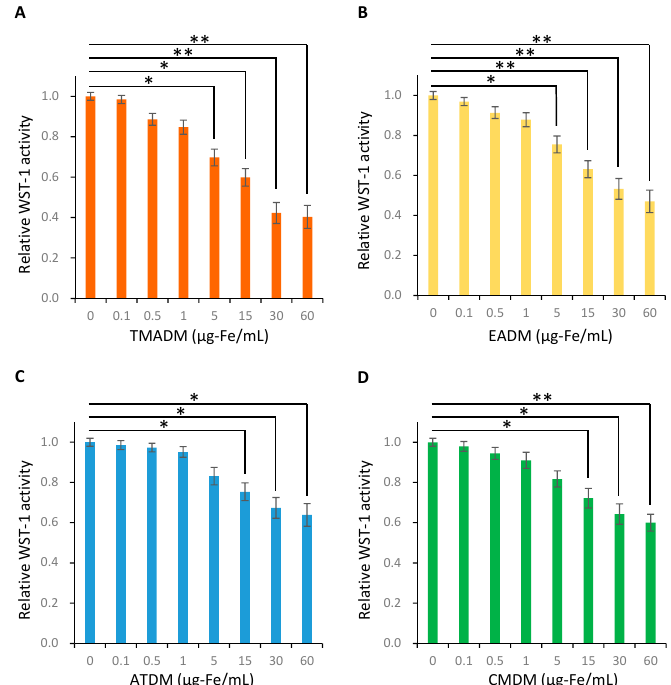
Figure 3. Metabolic activity of hepatocyte–endothelial cell heterospheroids labeled with polysac- charide magnetic iron oxide nanoparticles was estimated by the accumulation of formazan (WST-1 assay). The type of nanoparticle: ( A ) TMADM; ( B ) EADM; ( C ) ATDM; ( D ) CMDM. The heter- ospheroids were incubated for 2 d at 37 °C. After 48 h of cell culture, the heterospheroids were then incubated with various nanoparticles (0, 0.1, 0.5, 1, 5, 15, 30, and 60 μ g-Fe/mL) for 24 h at 37 °C. The assay started 3 d after the inoculation of the heterospheroids (mean ± range, n = 5). Relative WST-1 activity of the heterospheroids at each concentration of nanoparticles was converted using the con- trol group (non-labeled heterospheroids, 0 μ g-Fe/mL) as the 1.0 value. p -values are presented. Welch’s t -tests were used to compare WST-1 activity of the control group vs. the labeled groups. No mark = no significance, * p < 0.05, ** p < 0.01. Hepatocyte–endothelial cell heterospheroids maintained cytochrome P450-mediated monooxygenation [5]. Cytochrome P450 activity (CYP3A, estimated as testosterone 6- β - hydroxylation) of heterospheroids was decreased with various nanoparticles (Figure 4). The CYP3A activity was significantly different in the control group (non-labeled heter- 0.00.51.01.5 ospheroids) and the labeled groups (control group vs. TMADM and EADM, p < 0.01; con- trol group vs. ATDM and CMDM, p < 0.05). The heterospheroids labeled with anionic nanoparticles (ATDM and CMDM) showed higher activity than the cultured heter- ospheroids labeled with cationic nanoparticles (TMADM and EADM).